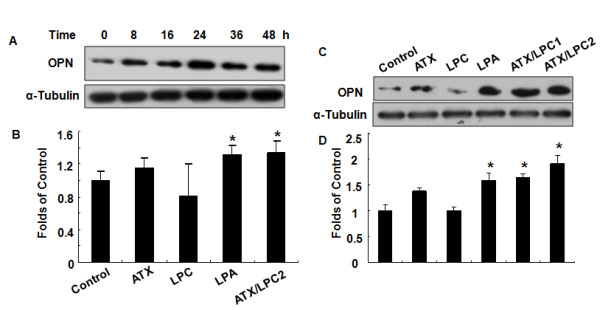
LPA and ATX/LPC induce OPN expression in SGC7901 cells. (A) Time course of OPN stimulation utilizing ATX (50 ng/ml) + LPC (20 μM) (ATX/LPC2). OPN expression was examined in SGC7901 cells by Western blot and real time-PCR. SGC7901 cells were treated with ATX, LPC, LPA, ATX/LPC1, ATX/LPC2 or DMEM/0.1% BSA. Total protein and RNA was extracted for Western blot (C) and real time -PCR (B), respectively. Figure1 D showed the densitometric ratio of OPN protein/α-tubulin. Statistical analysis was performed using Student's t test. *p < 0.05. The ATX/LPC concentration curve [4] for stimulated motility provides a justification for the concentrations of ATX/LPC chosen throughout the manuscript. LPA or ATX/LPC stimulates OPN production in additional cell lines (eg, SMMC7721 in our study: ATX-LPA axis induces expression of OPN in hepatic cancer cell SMMC7721) as well as in SGC7901 cells.